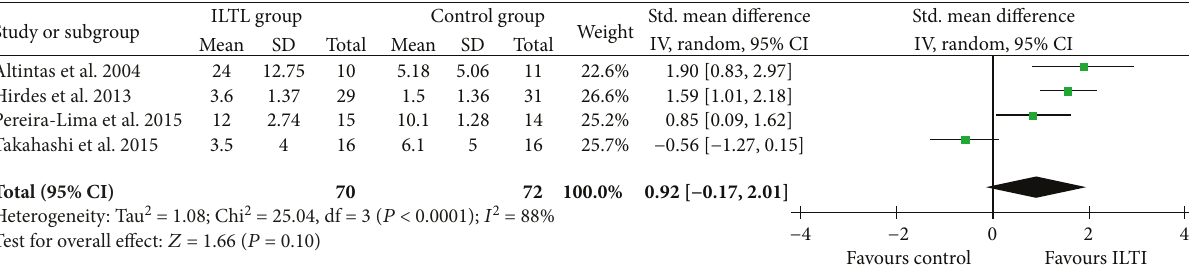
Figure 5: Forest plot of dysphagia-free time between ITI and